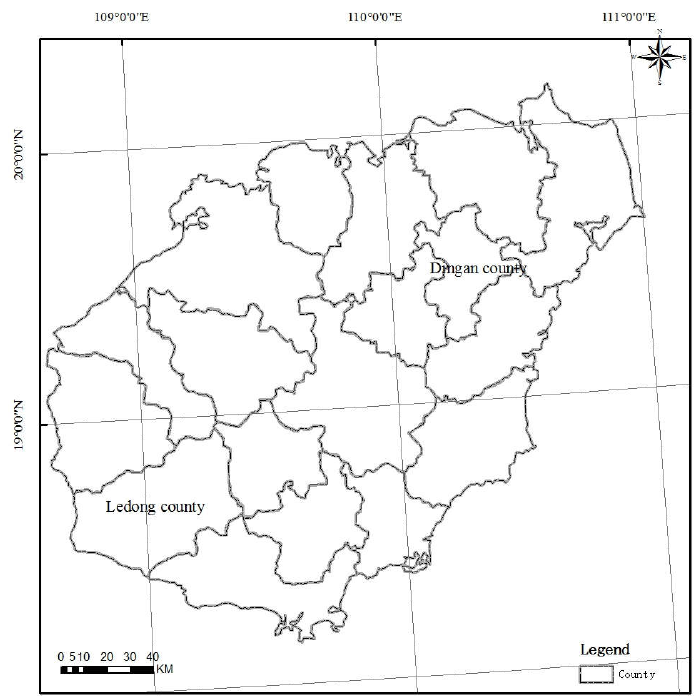
Figure 1. The map of study areas.